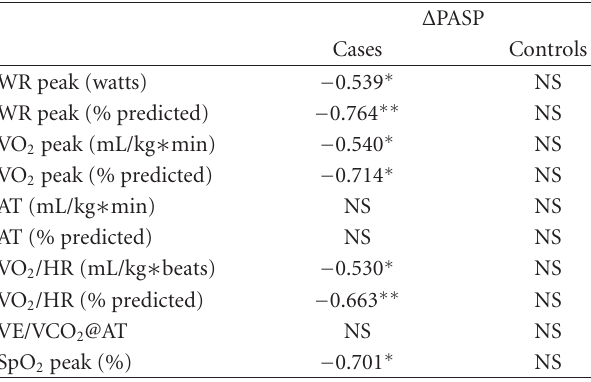
Table 4: Pearson correlations between Δ PASP and exercise variables in cases and controls.